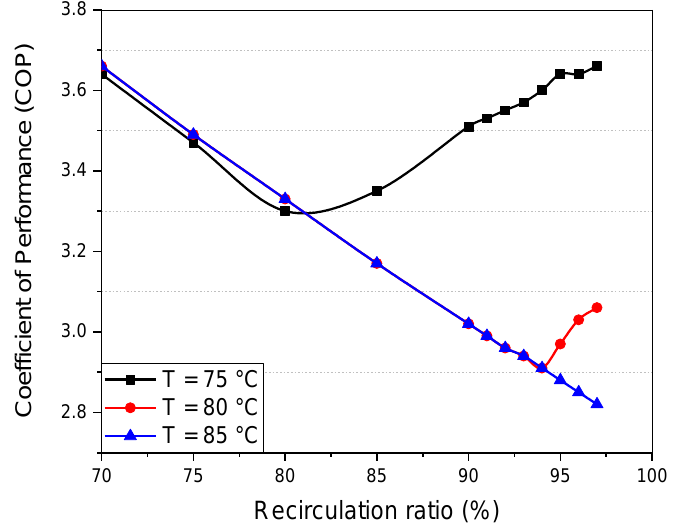
Figure 8. Coefficient of performance (COP) variation with recirculation ratio for the set-points of the heat pump at 75, 80 and 85 °C.